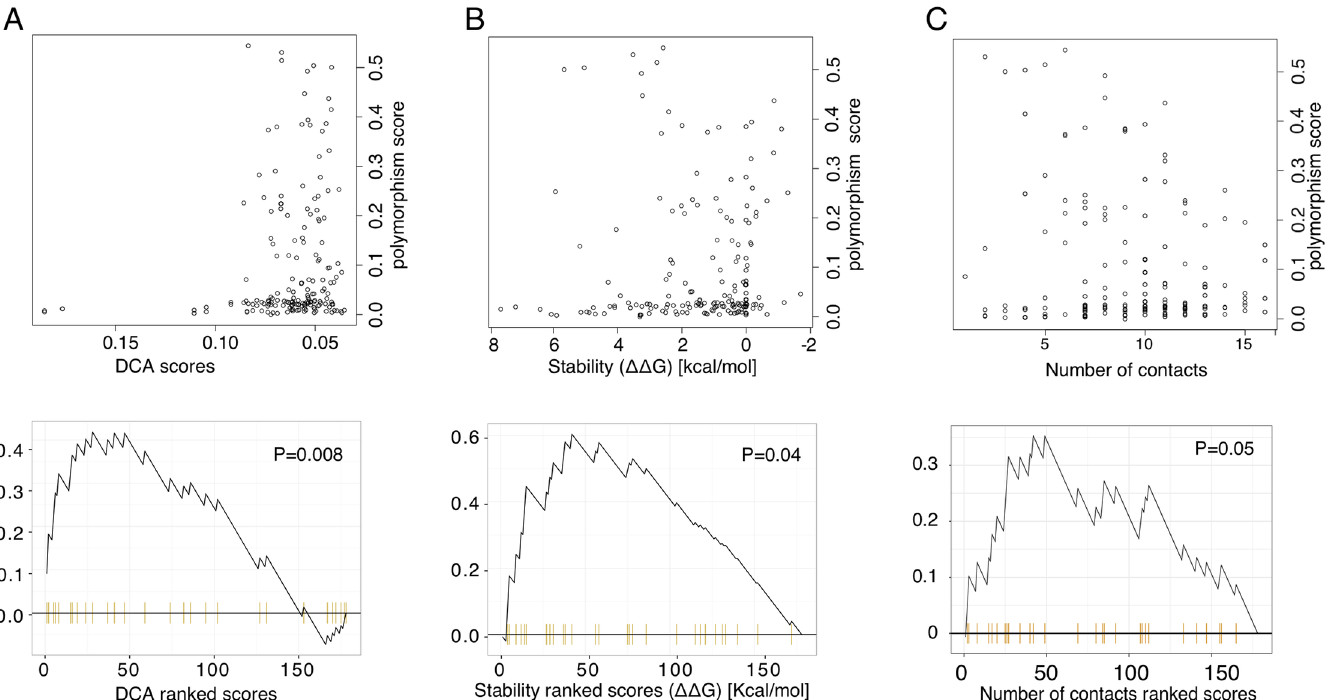
Fig 3. Polymorphic sites preferentially avoid co-evolving sites and sites involved in protein stability. Top. Plots of polymorphism scores versus: (A) DCA scores, (B) stability scores measured using FoldX (AlaScan function), (C) number of structural contacts. Bottom. Enrichment analysis of non-polymorphic sites with respect to (A) DCA scores, (B) stability scores and (C) number of structural contacts (x-axis shows the ranking of sites based on these values, sites with a polymorphism score lower than 0.01 are shown in yellow).